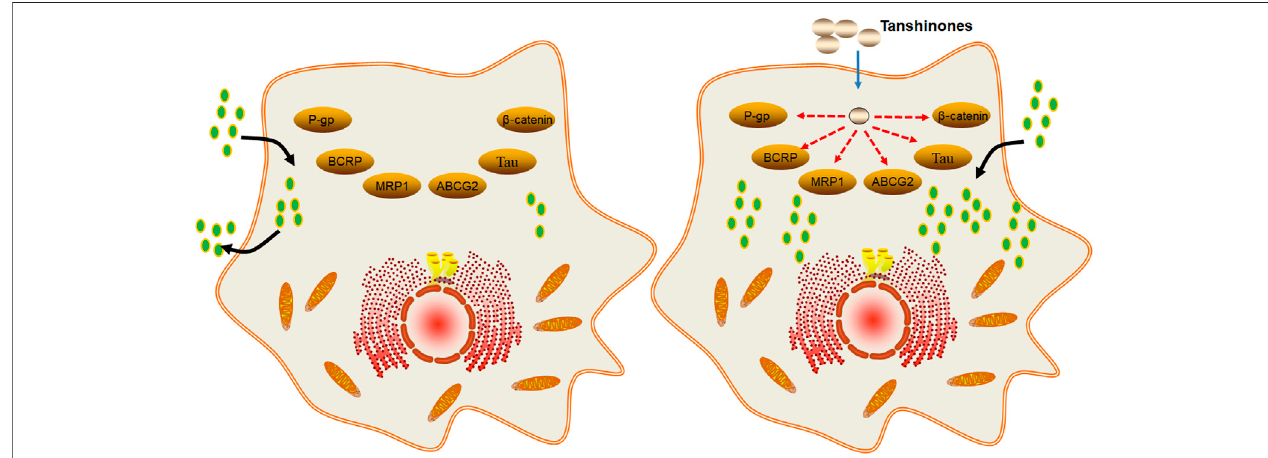
FIGURE 4 | Molecular mechanism of tanshinones increasing the ef fi cacy of chemotherapy and radiotherapy. Tanshinones inhibit protein expression of P-gp, BCRP,MRP1,ABCG2,Tau,and β -catenin.P-gp,P-glycoprotein;multidrugresistance-associatedprotein1;ABCG2,ATPbindingcassettesubfamilyGmember2;Tau, microtubule-associated protein; β -catenin, beta-cadherin – associated